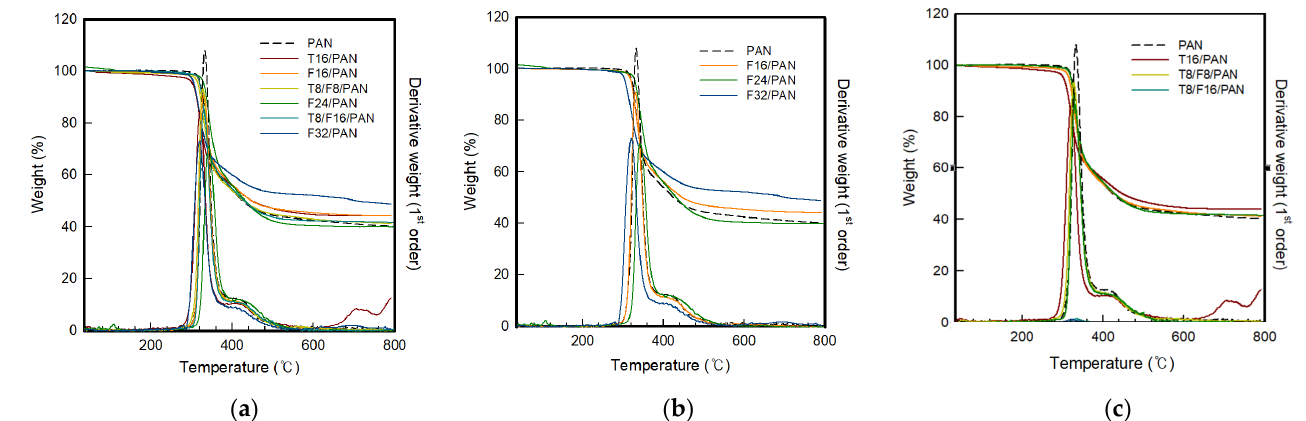
Figure 9. TGA and first derivative curve of PAN-based conductive yarn with various contents of carbon nanomaterials ( a ) Total, ( b ) CNF, and ( c ) blended CNT and CNT/CNF. Table 9. TGA of the PAN-based composite yarn with different contents of carbon nanomaterials. Sample